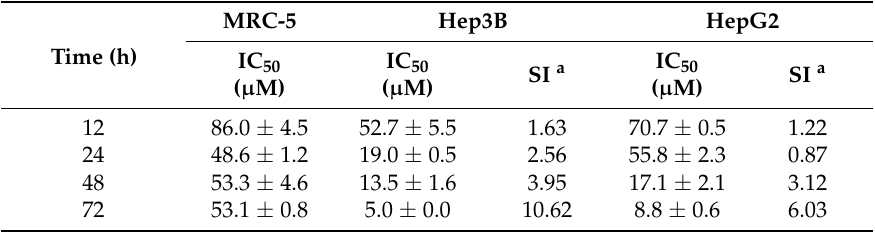
Table 2. The time-dependent effects of pinnatane A on liver cancer cell lines.